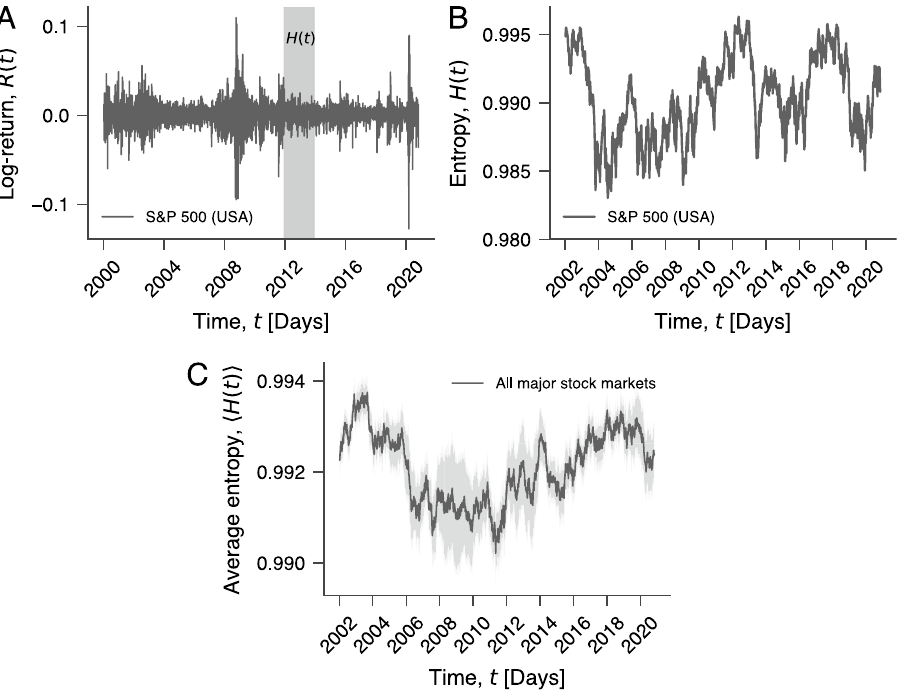
Figure 1. Defining the informational efficiency of stock markets with permutation entropy. ( A ) Log-return time series R ( t ) of the S&P 500 daily closing prices from January 1, 2000 to October 31, 2020. The shaded area illustrates a 500-day sliding window (2 years of stock market operation) used for calculating the permutation entropy H ( t ). ( B ) Time evolution of the permutation entropy H ( t ) with embedding dimension d = 4 (“Methods” section for details) of the S&P 500 index. ( C ) Time evolution of the average value of the efficiency (cid:31) H ( t ) (cid:30) of all 43 stock markets in our study (shaded band represents the standard error of the